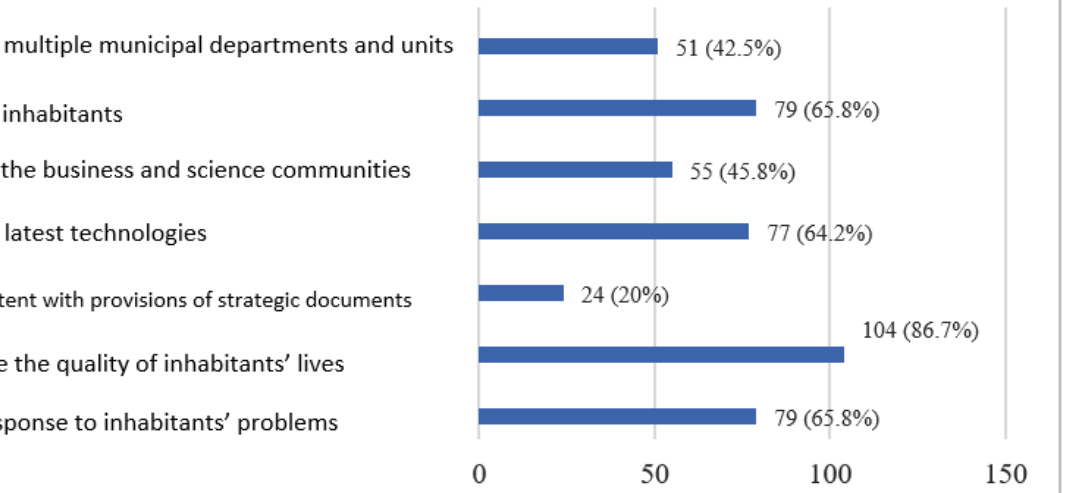
Figure 11. The expected smart city project criteria. Source: own study based on questionnaire sur- veys.